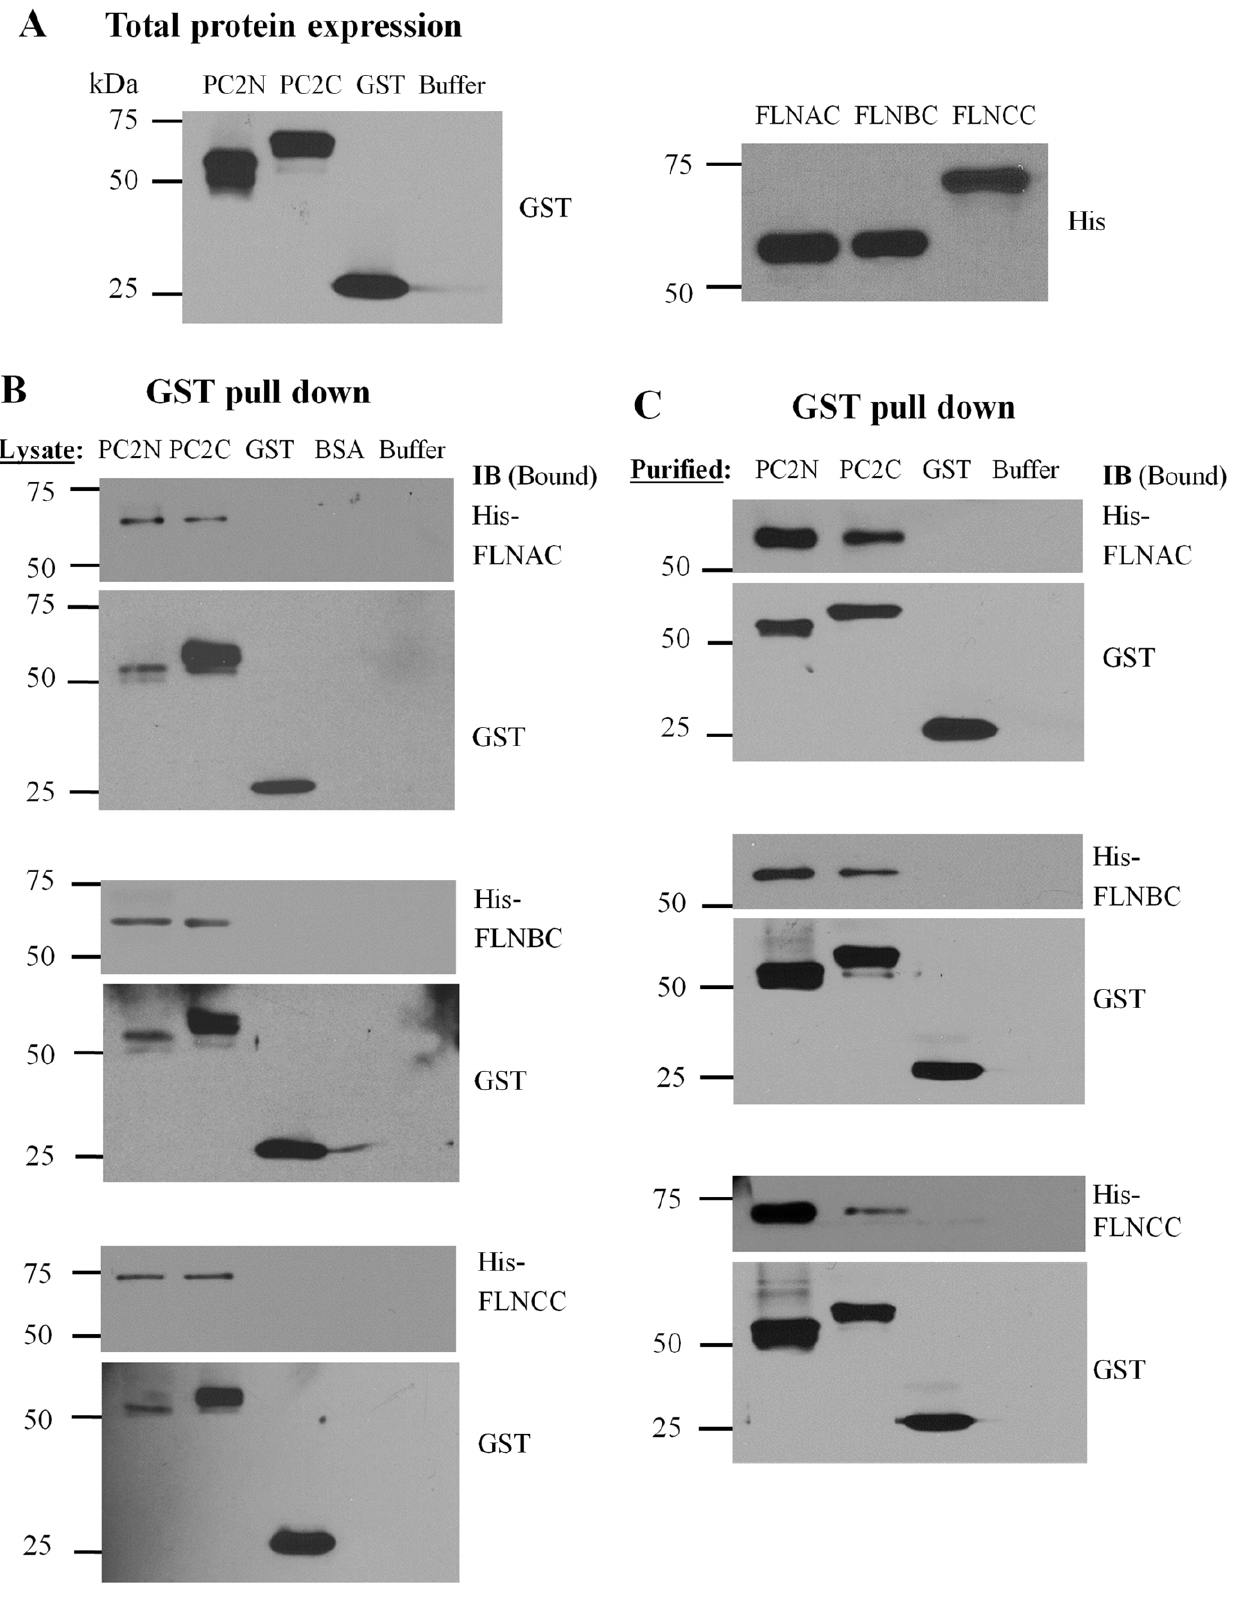
Figure 2. Interaction between PC2 and filamins by GST pull-down. ( A ) Total expression of purified GST- or His-tagged proteins. Left panel, representative data obtained with an anti-GST antibody showing purified GST fusion proteins and buffer from E. coli . Right panel, IB imaging obtained with an anti-His antibody showing purified His-tagged FLNAC, FLNBC and FLNCC from E. coli . ( B ) E. coli lysates from cells expressing GST-